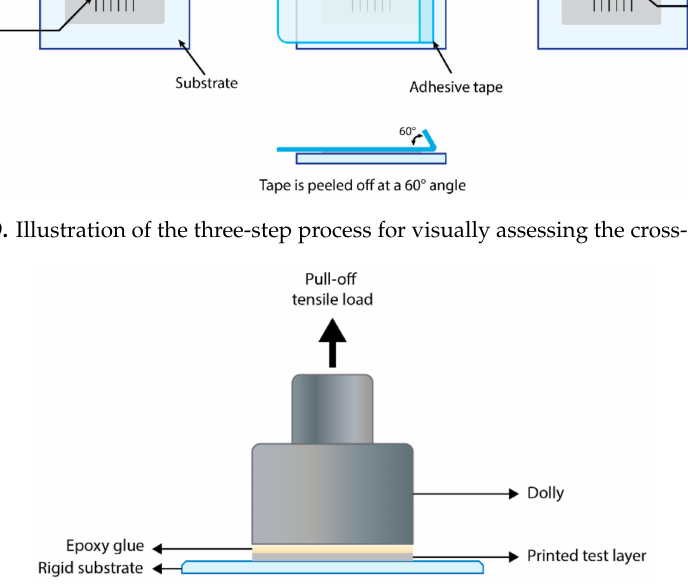
Figure 10. Schematic of the assembly for the pull-o ff test method.